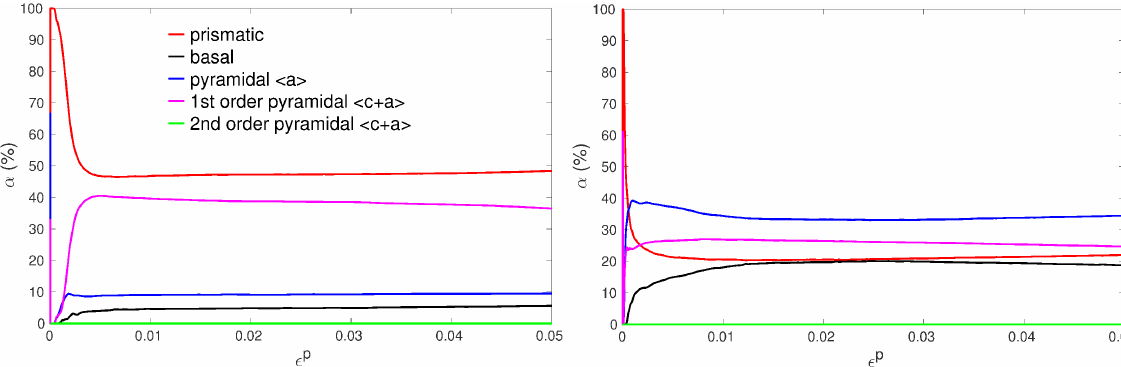
Figure 9. Relative activities of slip families ( α ) predicted by the model for specimen RR 9.8 ( left ) and RT 9.8 ( right ).